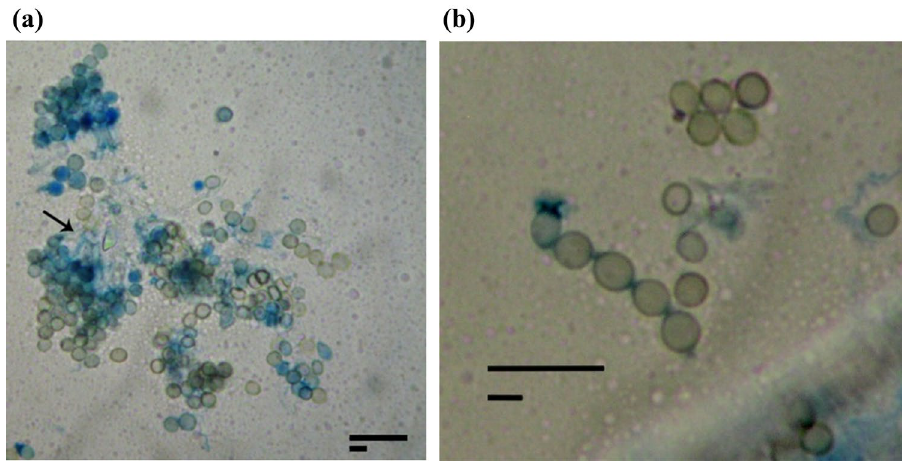
Fig. 3 Penicillium-like con- idiophores from a tape mount from book #11 stained with 0.05% Analine blue in lactic acid. The arrow indicates the branched conidiophore. Scale bars are 10 μm and 3 μm ( a ). Chains of spores from a tape mount from book #1 stained with 0.05% Analine blue in lac- tic acid. Scale bars are 10 μm and 3 μm ( b )